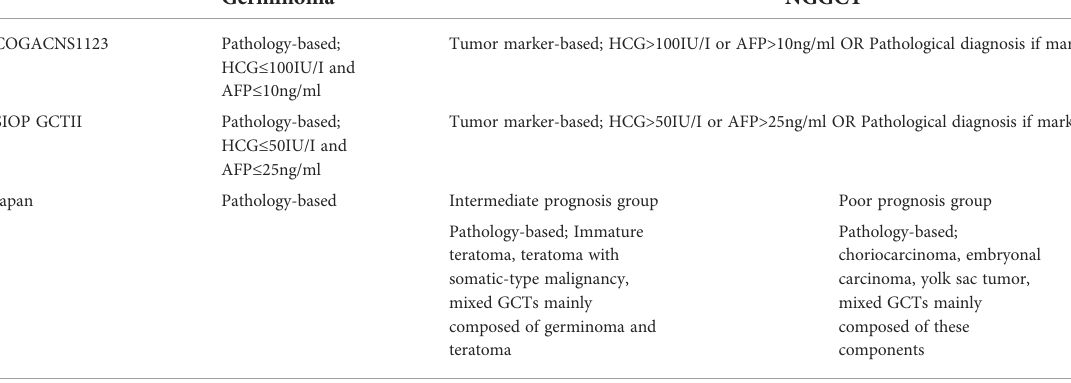
TABLE 1 Difference in diagnosis and risk strati fi cation among the US, Europe, and Japan.